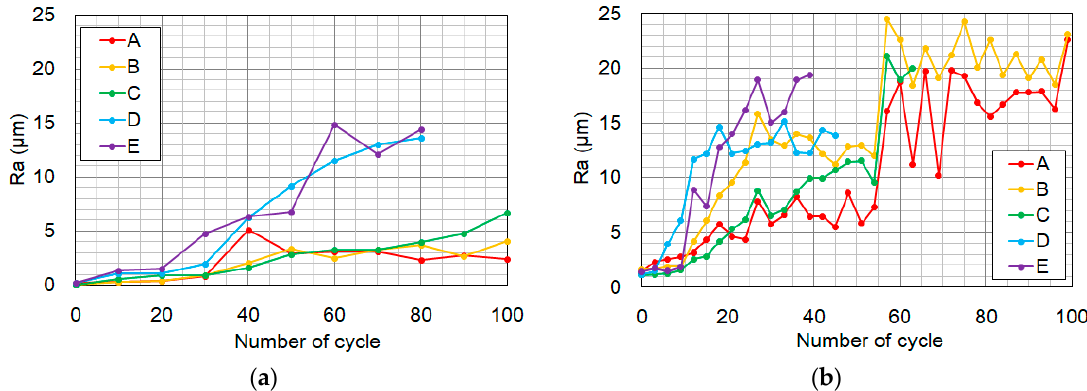
Figure 10. Change in Ra with number of cycle in the 100-cycle tests. ( a ) 1 mm air gap; ( b ) 2 mm air gap.